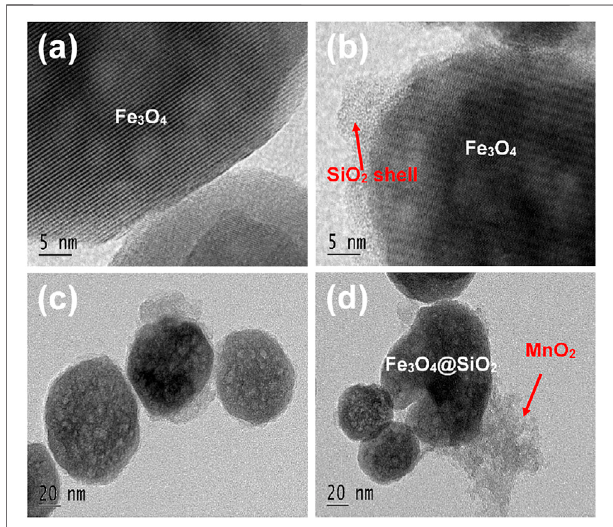
FIGURE 2 | TEM images of (A) Fe 3 O 4 , (B) Fe 3 O 4 @SiO 2 , and (C,D) Fe 3 O 4 @SiO 2 -MnO 2